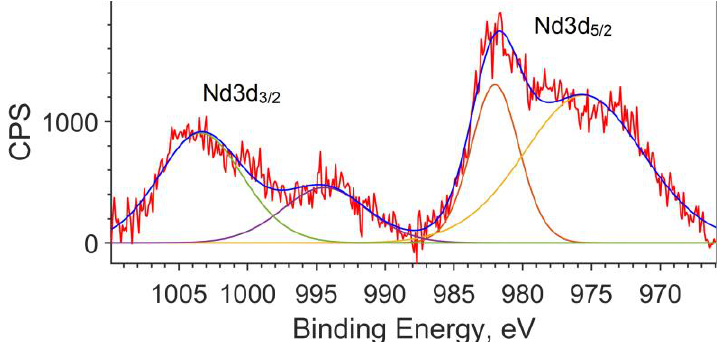
Figure 3. Spin–orbit splitting of Nd3d for the NdFe (1 − x) Co x B oxide powders with x = 0. Figure 3. Spin – orbit splitting of Nd3d for the NdFe (1 − x) Co x B oxide powders with x = 0.